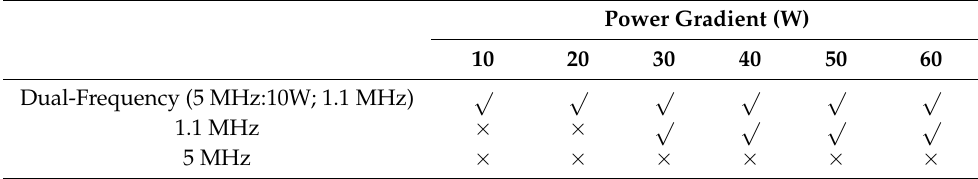
Table 4. Acoustic threshold for the single and dual frequency HIFU with PFP@Polymer